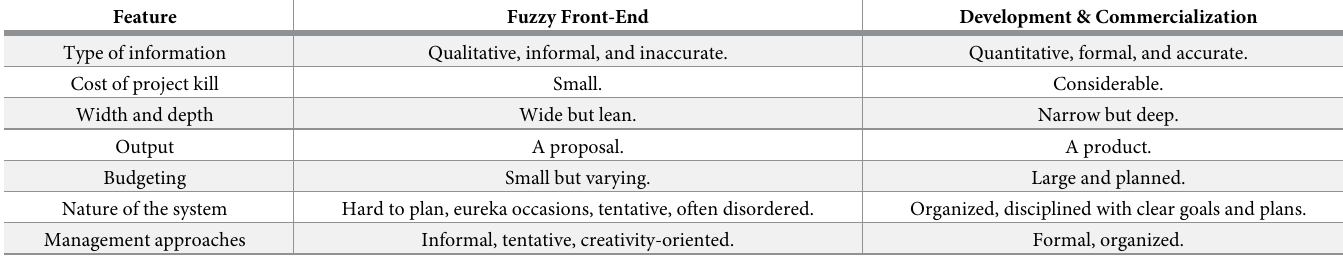
Table 1. Fuzzy front-end vs development and commercialization